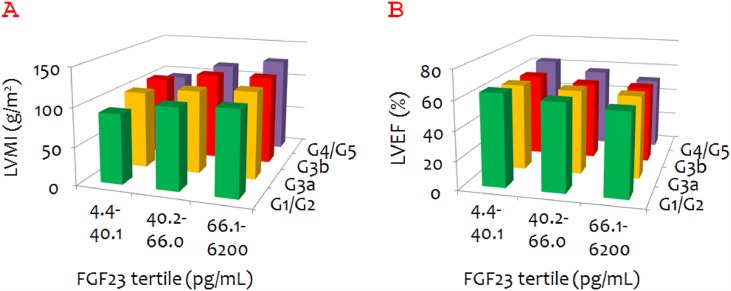
Mean left ventricular mass index (LVMI) and left ventricular ejection fraction (LVEF) according to FGF23 tertile and chronic kidney disease (CKD) stage.A. Mean LVMI according to FGF23 tertile and CKD stage. B. Mean LVEF according to FGF23 tertile and CKD stage.